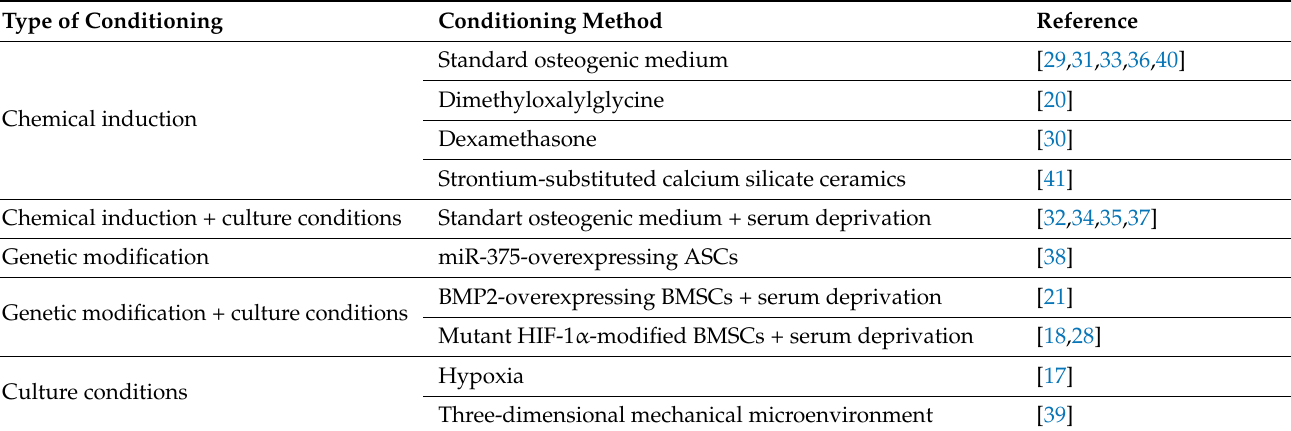
Table 1. Conditioning methods.